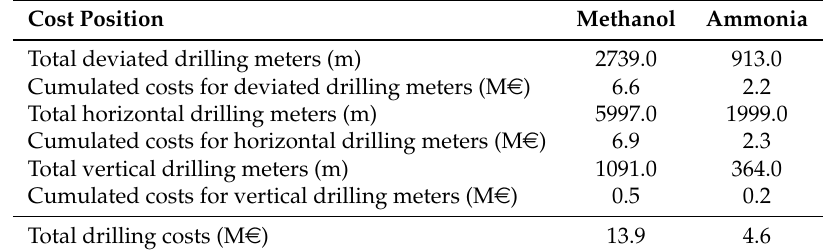
Table 6. Drilling meters and costs in the offshore methanol and ammonia production scenarios.